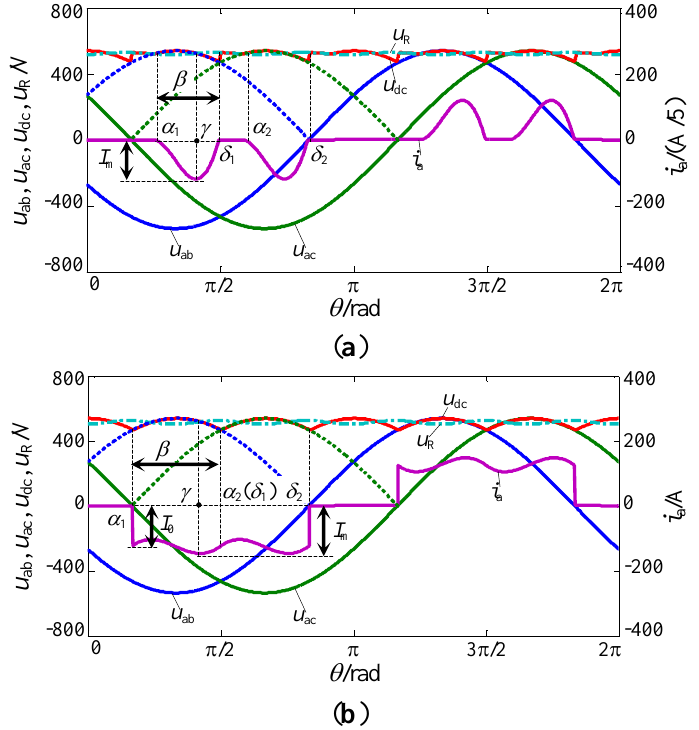
Figure 2. Operating characteristics of charger: ( a ) current in DCM (Discontinuous Current Mode) and ( b ) current in CCM (Continuous Current